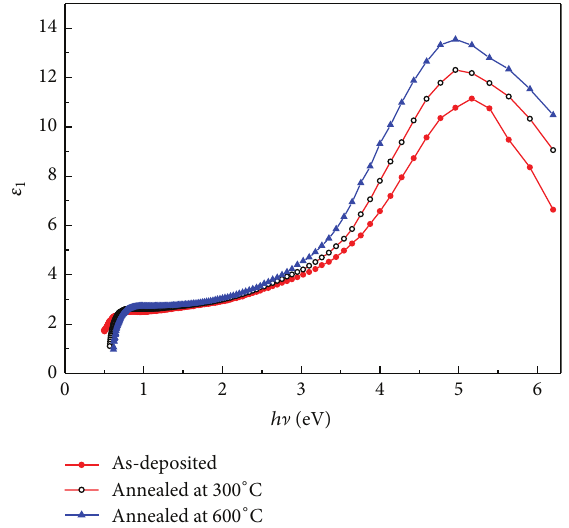
Figure 4: Dependence of the real part of dielectric function on the photon energy at different annealing